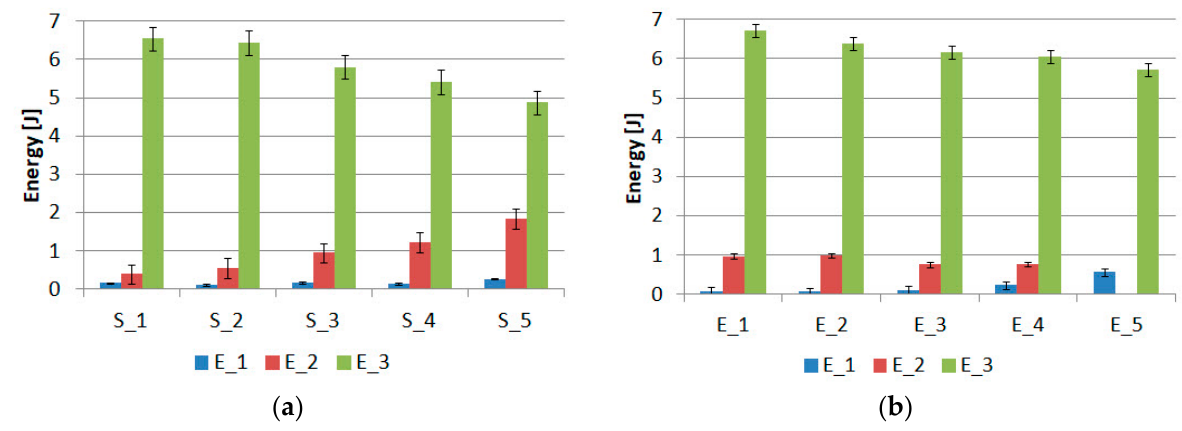
Figure 16. Summary of damage energy for samples of group: ( a ) “S” and ( b ) “E”. In each case, the energy level associated with the damage of the double-sided adhesive tape dominates. In both groups of “S” and “E” specimens, there is also the effect of decreasing the energy associated with the work of the double-sided tape as the diameter of the internal bond increases. Changing the internal bond from 8 mm to 20 mm results in an energy decrease of 25.5% for the “S” group samples and 14.7% for the “E” group samples. The smaller decrease for the “E” group samples is due to the fact that there is an internal stiff bond, which relieves the double-sided tape much more. The lowest energy, regardless of the type of sample, is characterized by the first stage of joint work. The energy achieved is in the range of 0.08 J–0.57 J. The energy for the second stage is in the range of 0.4 J–1.84 J. The larger effect on the energy in the second stage of the change in diameter can be observed for the samples of the “S”